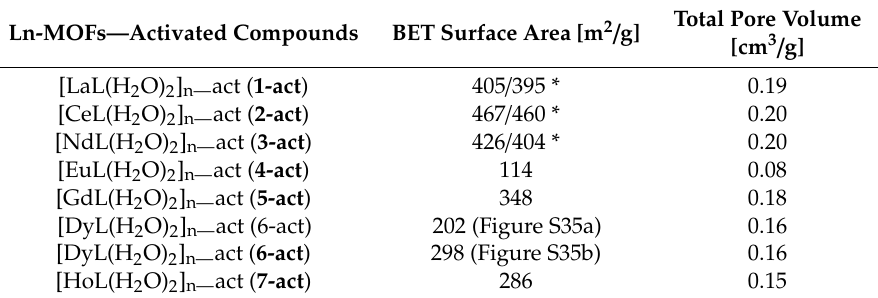
Table 1. BET surface area and total pore volume for Ln-MOFs